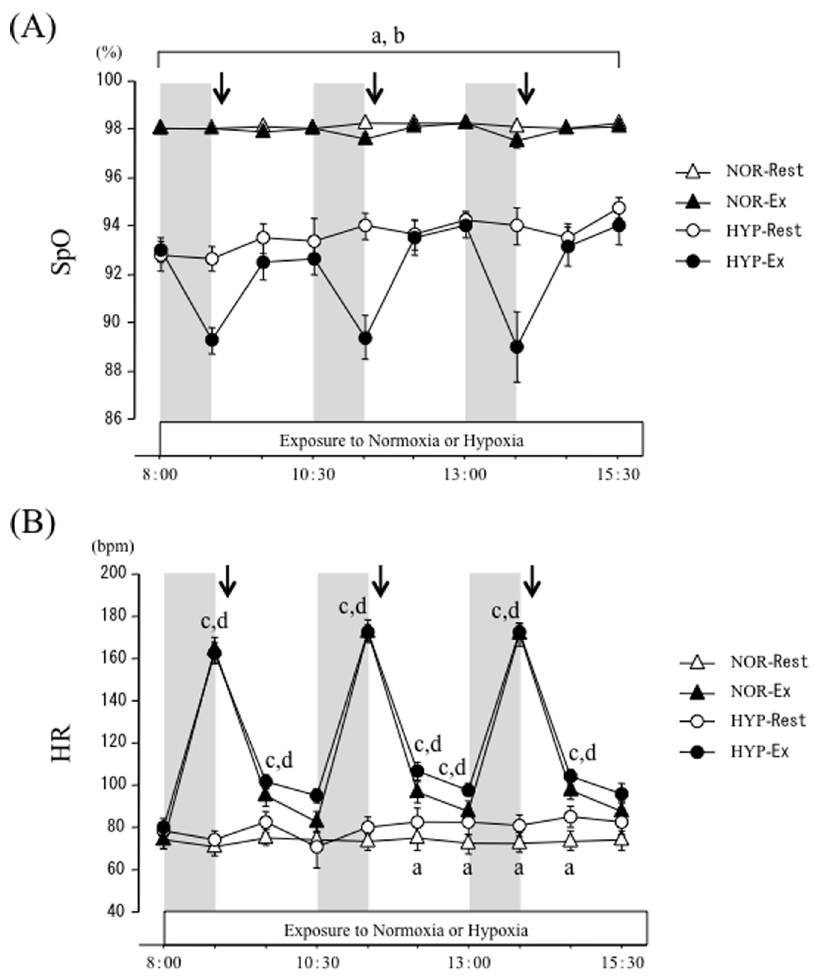
Figure 2. Time-course changes of SpO 2 (A) and HR (B) over 7.5 h. Each period of exercise is indicated by the shaded boxes. The arrow indicates the time of meal consumption. a; P , 0.05, NOR-Rest vs. HYP-Rest. b; P , 0.05, NOR-Ex vs. HYP-Ex. c; P , 0.05, NOR-Rest vs. NOR-Ex. d; P , 0.05, HYP-Rest vs. HYP-Ex.